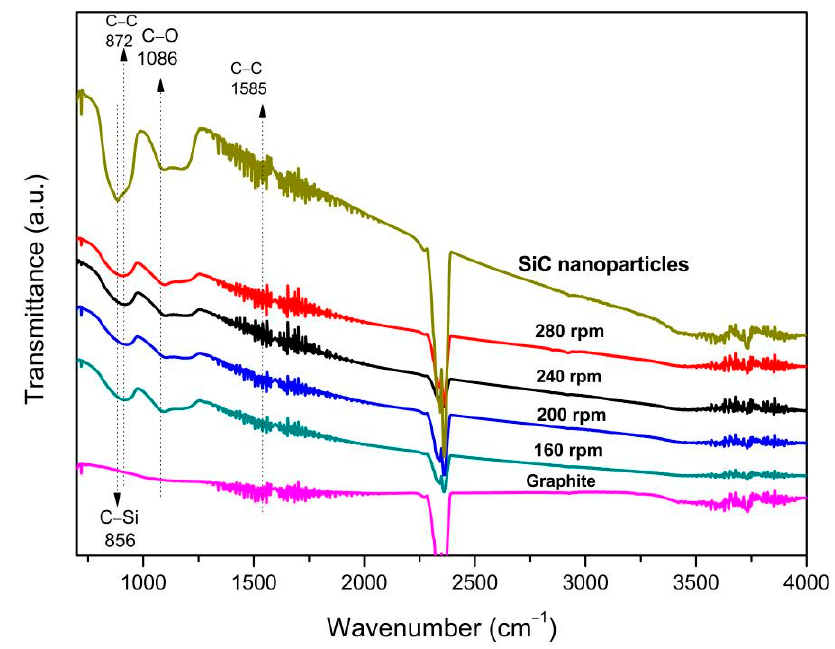
Figure 11. FTIR spectra of the composites at different rotational speeds and initial materials .